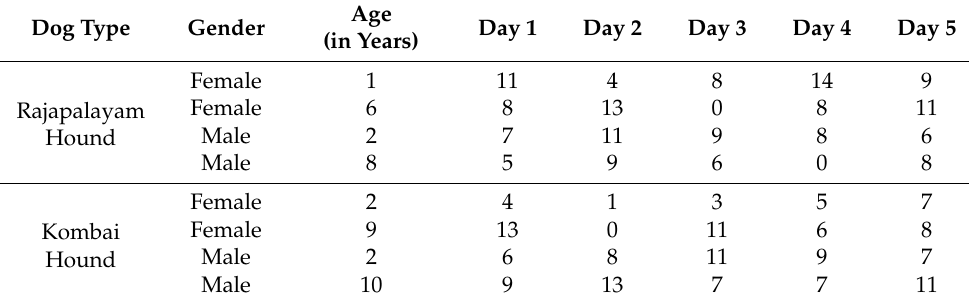
Table A4. Dog Sounds Recorded When Playing with Owner.